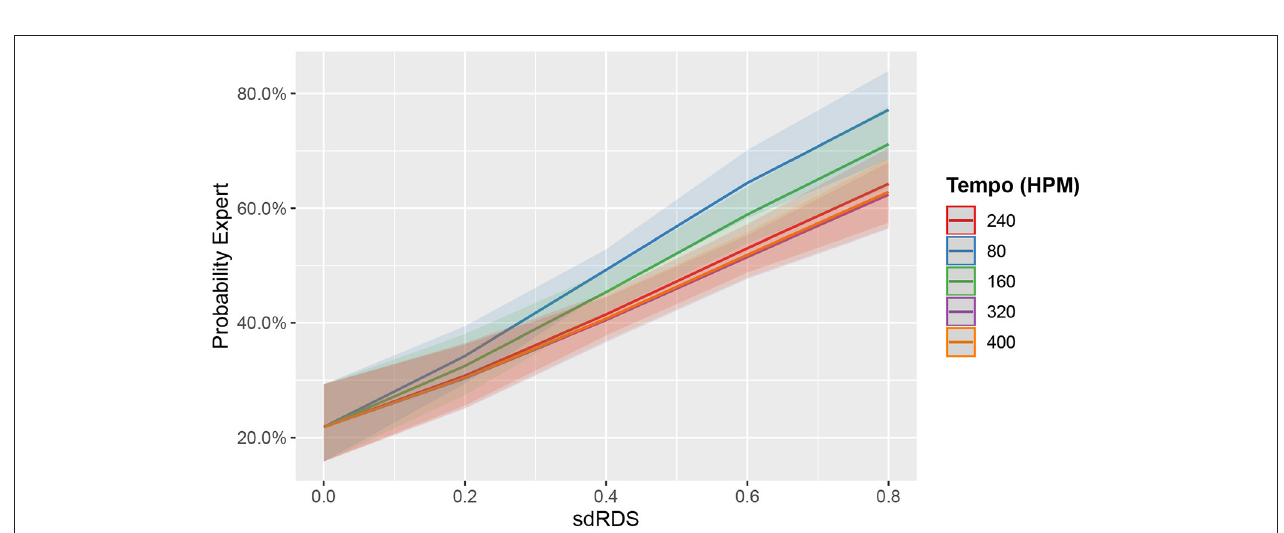
plot shows a stronger tendency to play in-phase in the